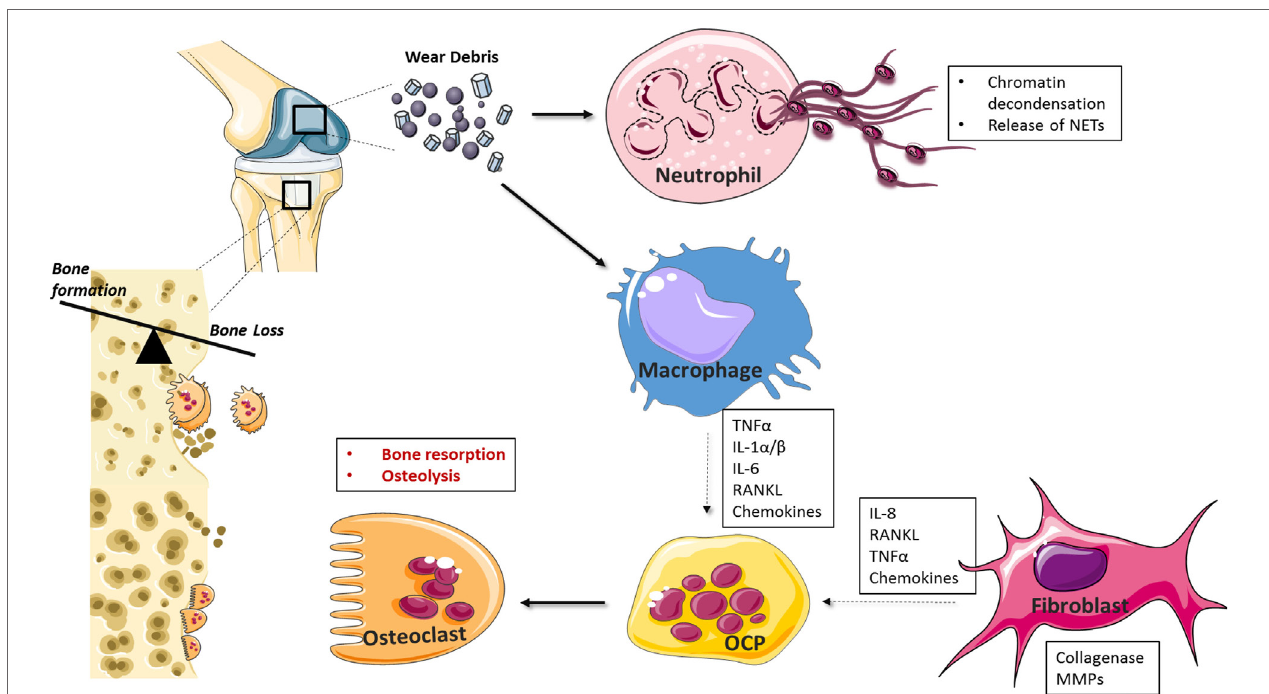
FiGURe 2 | Cellular mediators of periprosthetic osteolysis. Wear-debris particles generated from prostheses activate resident and infiltrating macrophages, fibroblasts, and neutrophils at the site of implantation. Neutrophil recognition of biomaterials drives neutrophil extracellular trap (NET) formation while macrophage and fibroblast-induced chemokine production facilitates further leukocyte recruitment to the implant interface. Cytokines, such as tumor necrosis factor (TNF)- α and IL-1, drive inflammation and, together with RANKL, can induce the differentiation of osteoclast precursor cells (OCPs) into activated bone resorbing cells. Matrix metalloprotease (MMPs) and collagenases contribute further to catabolic processes and aseptic implant